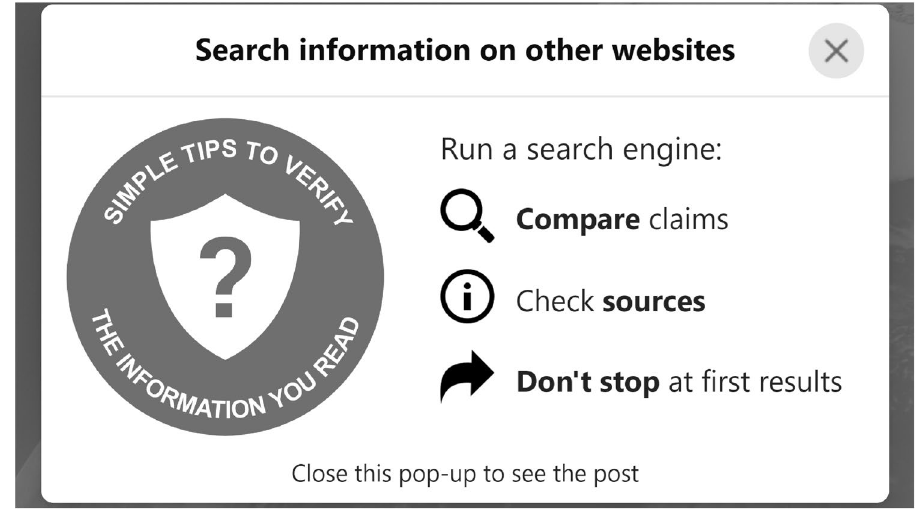
Figure 1. Screenshot of the pop-up presented to